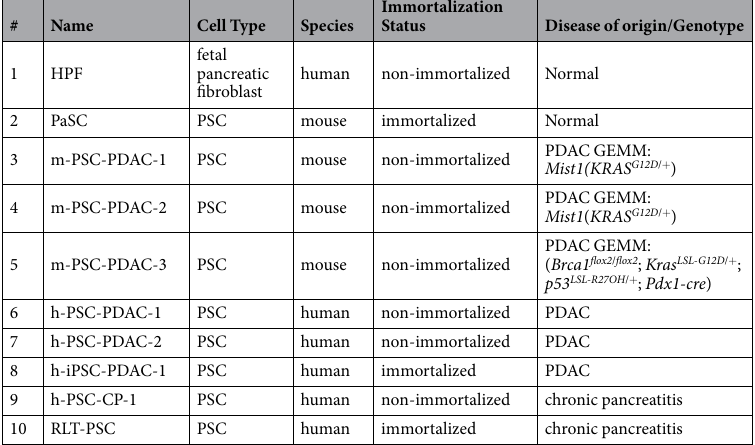
Table 1. Human and murine pancreatic stellate cell lines utilized in vitro . Details, including cell type, species of origin, immortalization status, and disease of origin, are provided for each cell line (PDAC indicates pancreatic ductal adenocarcinoma , GEMM indicates genetically engineered mouse model